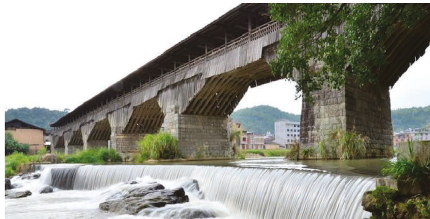
Figure 7: Wan’an Bridge, the longest ancient Chinese wooden arcade bridge in the